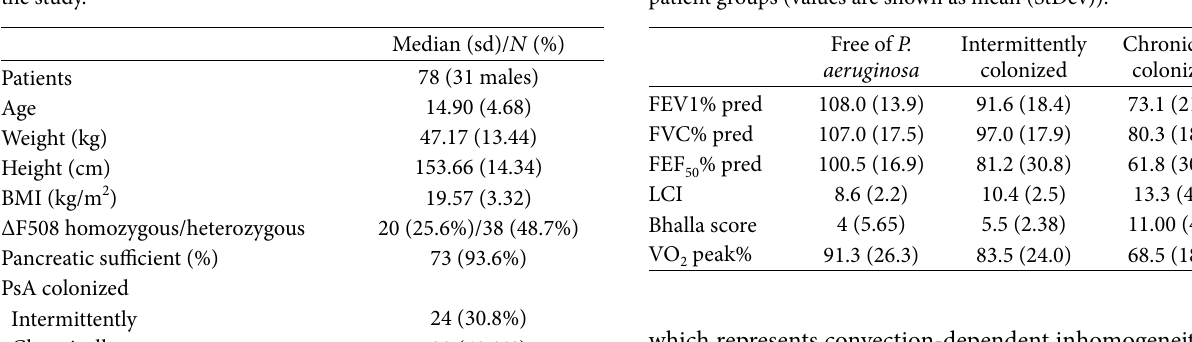
Table 1: Demographical characteristics of patients participating in the study.